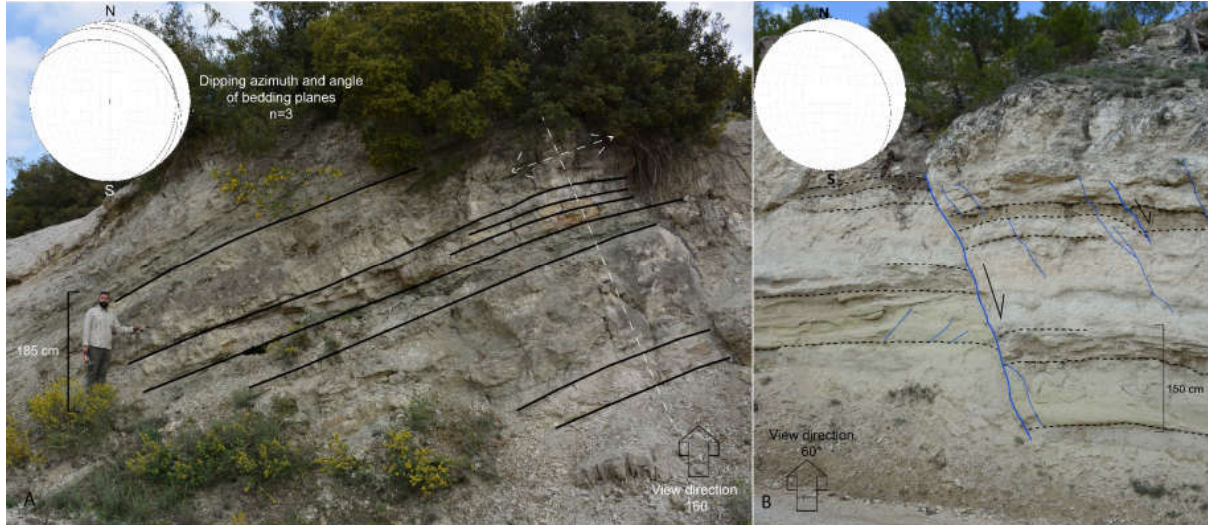
Figure 9. Field photographs showing folded, tilted and faulted bedding layers of the Ulubey limestone. ( A ) Dip azimuth and angle of the bedding planes are indicated on an equal area Stereonet. X-Y-Z coordinates: 653278-4285643, 528 m. ( B ) Dip azimuth and angle of the fault plane are shown on the equal area Stereonet. X-Y-Z coordinates: 656677-4282632, 724 m. UTM Zone 35 coordinates.